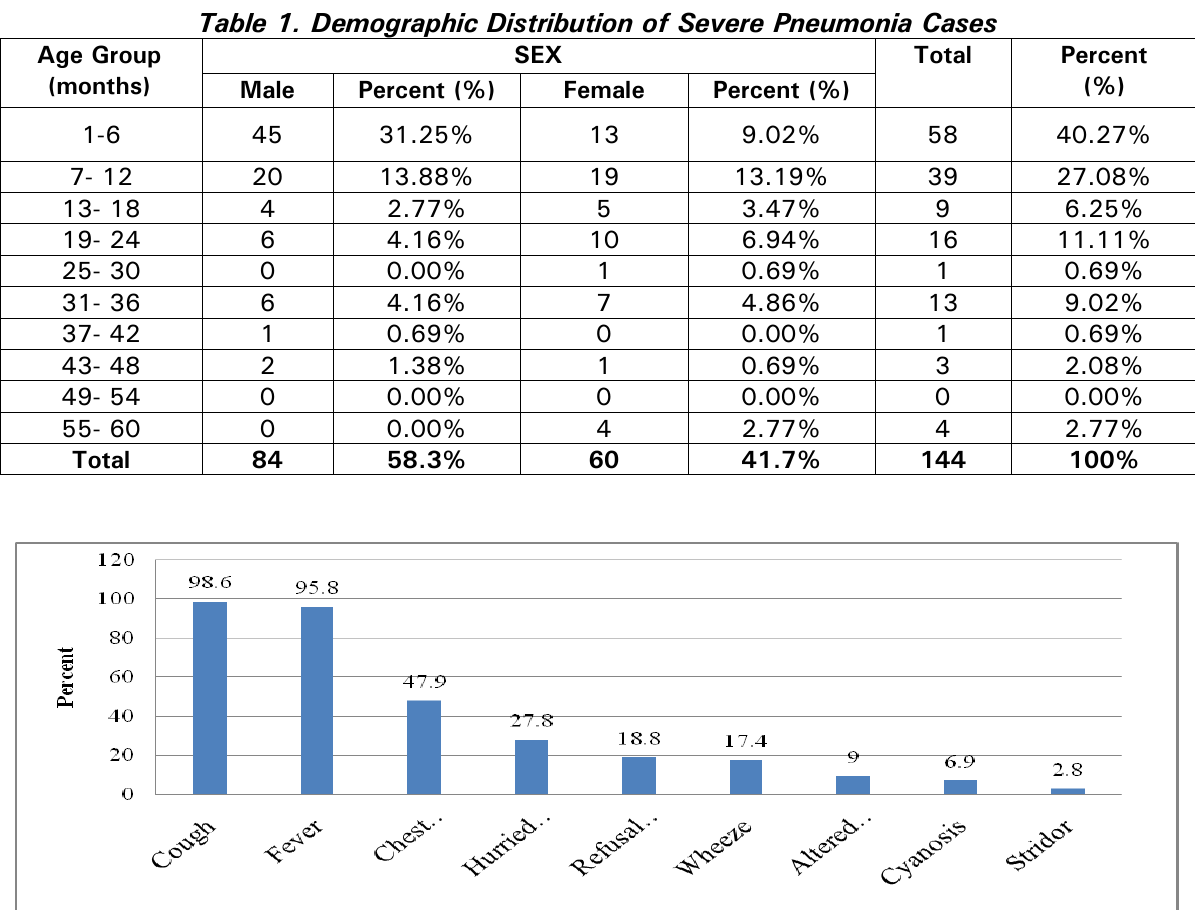
Figure 1: Clinical presentations of severe pneumonia